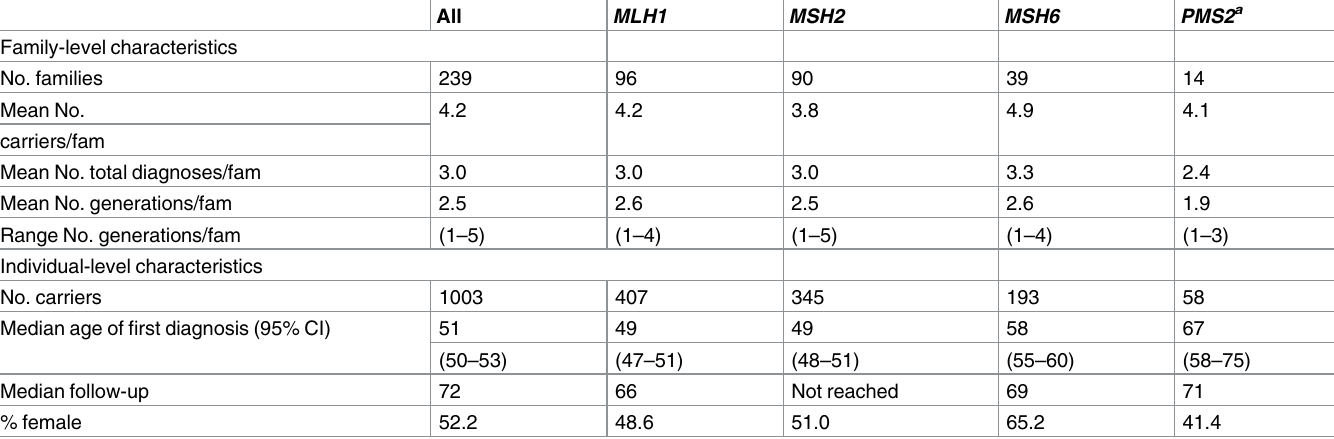
Table 1. Clinical characteristics of the analyzed LS cohort.